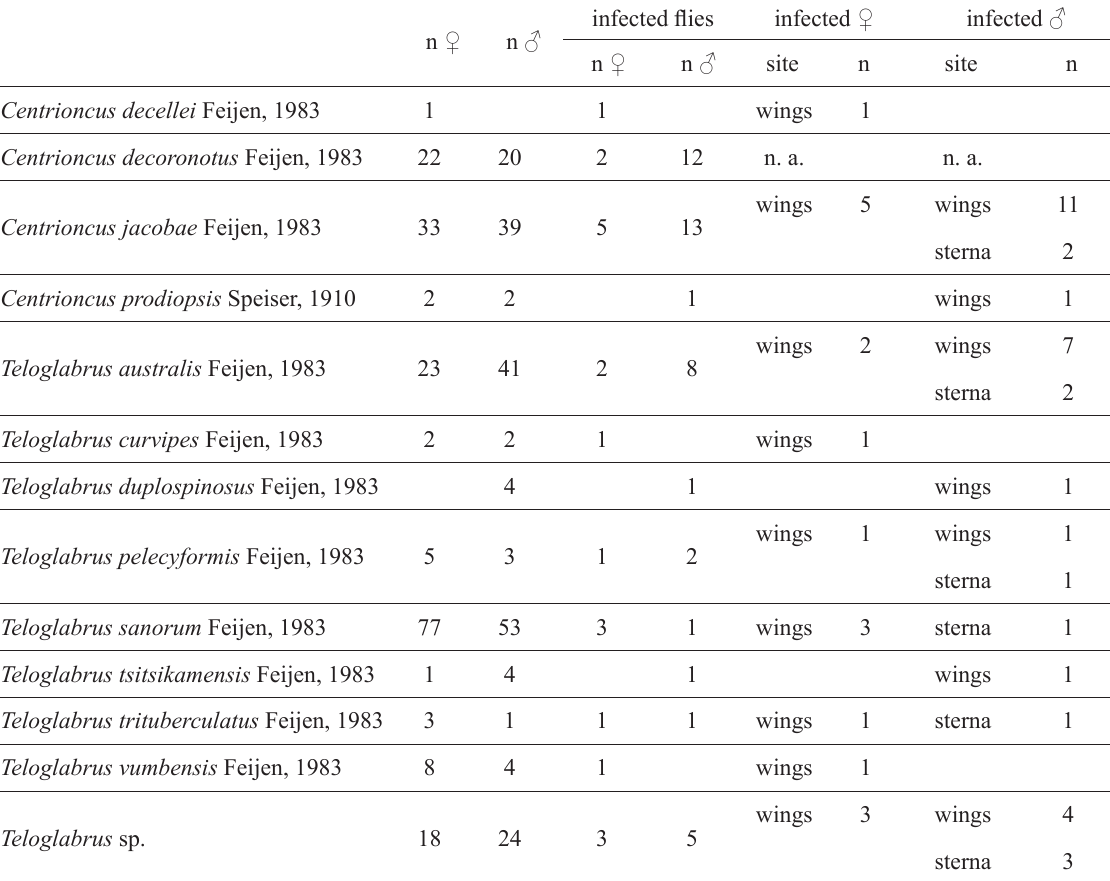
Table 2 . Prevalence of R. forcipatus W.Rossi & Feijen sp. nov. on host species of Centrioncus Speiser, 1910 and Teloglabrus Feijen, 1983. Given are: totals of hosts examined (♀ and ♂), totals with Rhizomyces Thaxt., infection location. (n. a. = not